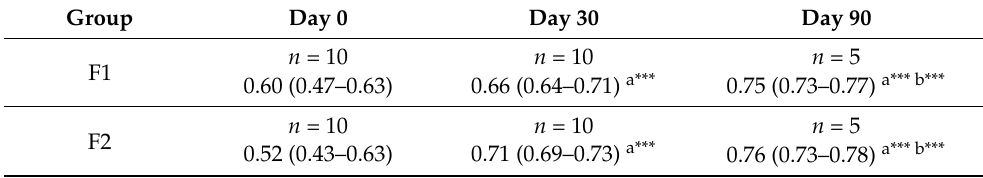
Table 2. Relative bone density of critical-size segmental femoral defects in rats from the different experimental groups. Data are presented as medians